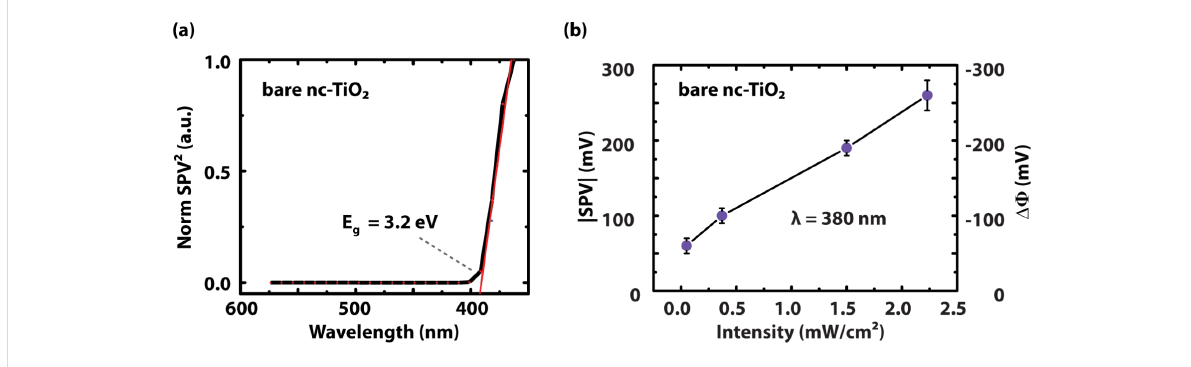
Figure 5: SPV for bare nc-TiO 2 in dependency on (a) the wavelength and (b) on the light intensity under super-bandgap illumination (380 nm). The bandgap of the material was extracted by SPV spectroscopy.